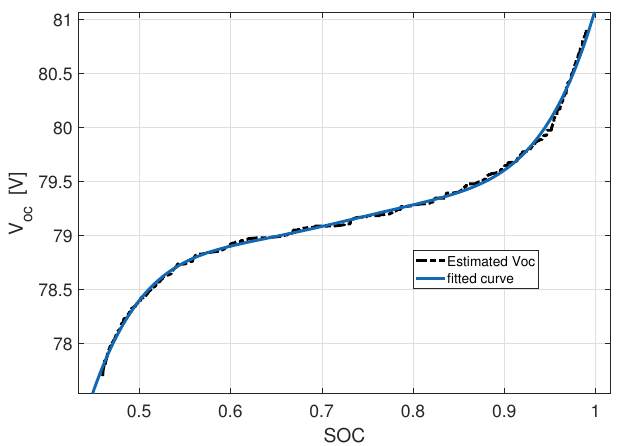
Figure 9. Estimated and fitted V oc vs. SOC (DP model).